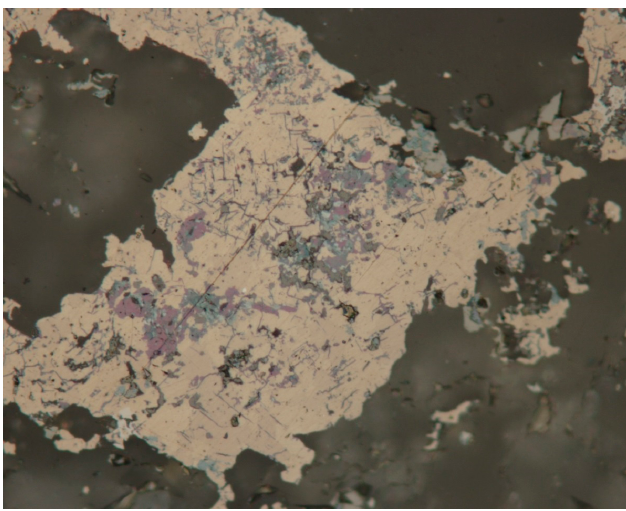
Figure 31. Brown eskebornite with inclusions of violet umangite, blue berzelianite, and dark grey uraninite. Middle grey minor tetrahedrite is in the association. Reflected light, one polarizer. FOV is 210 μ m. P ř íbram, dump at shaft 16. Photo by P. Škácha.